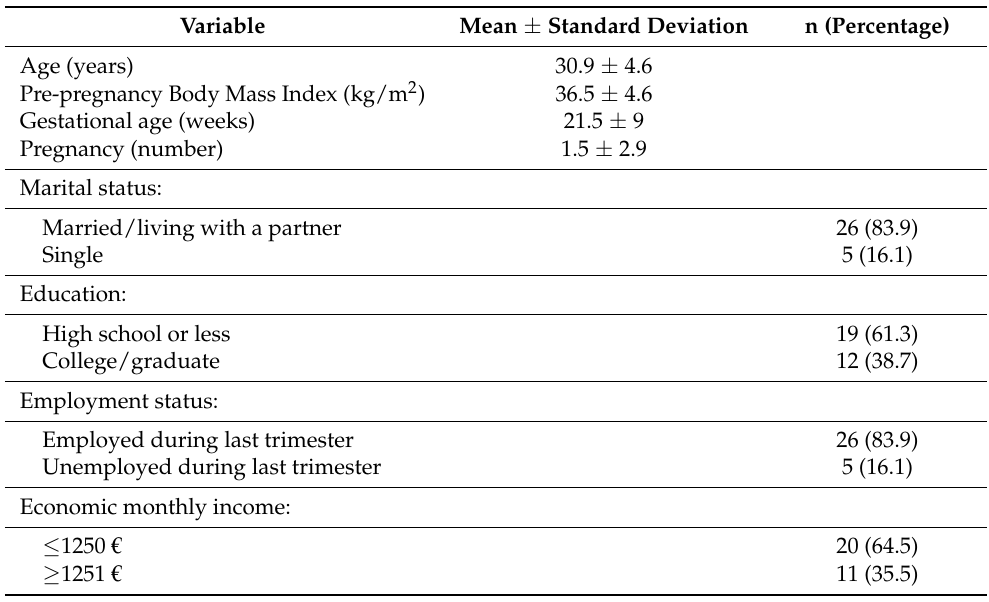
Table 1. Sample characterization for sociodemographic and obstetric variables (data provided: mean ± standard